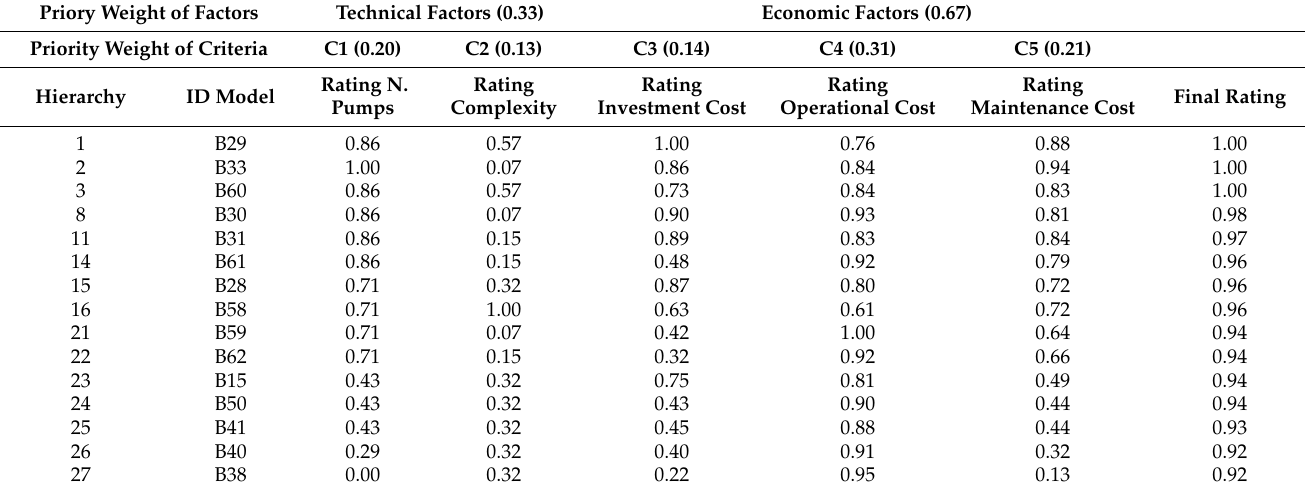
Table 13. Rating of the criteria and overall rating for each alternative